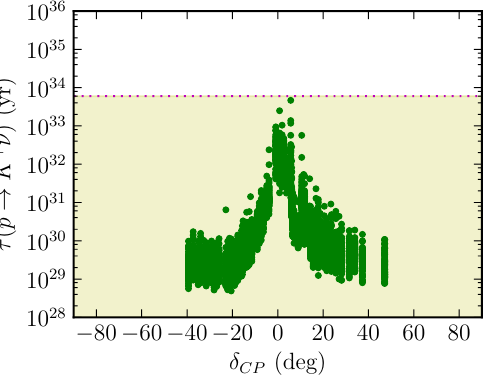
Figure 8 . Comparisons of the Dirac CP phase angle to the K + (cid:22) (cid:23) partial lifetime, for the fermion (cid:12)ts discussed